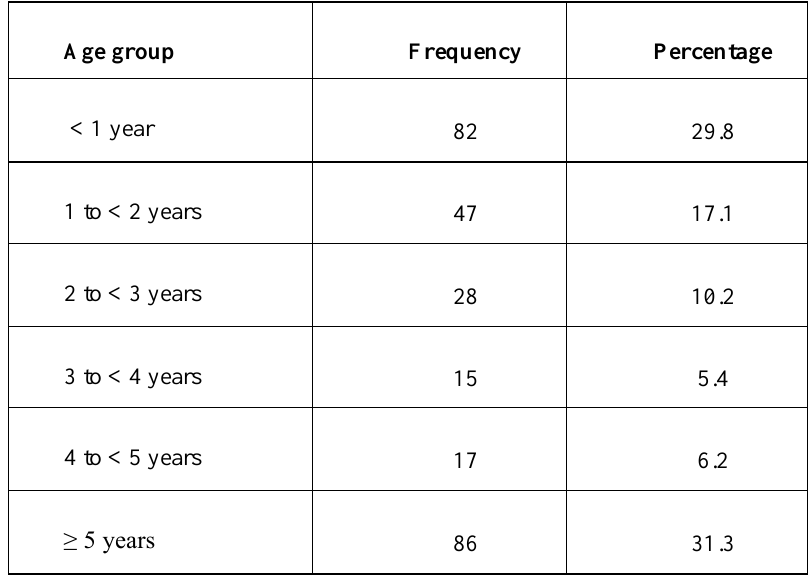
Table 2. Age group distribution of studied